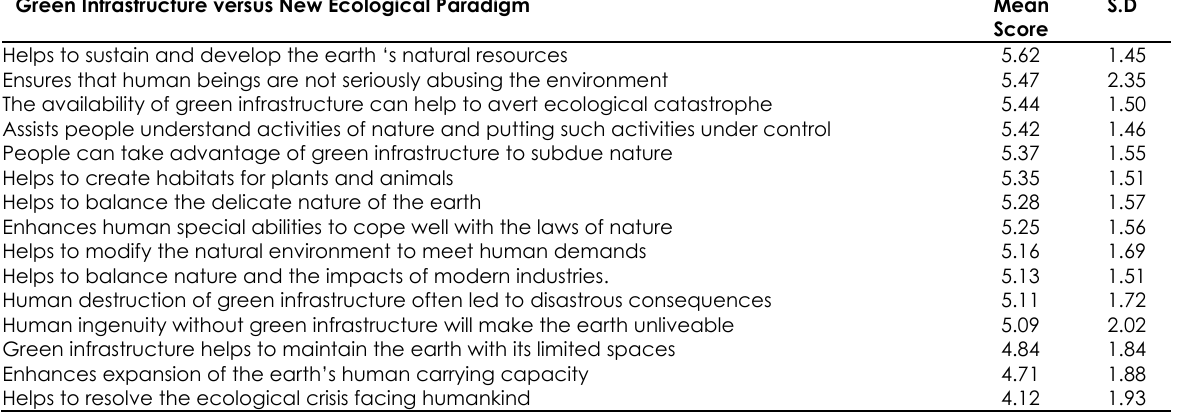
Table 3. Respondents’ rating of influence of green infrastructure in endorsement of the NEP. Green Infrastructure versus New Ecological